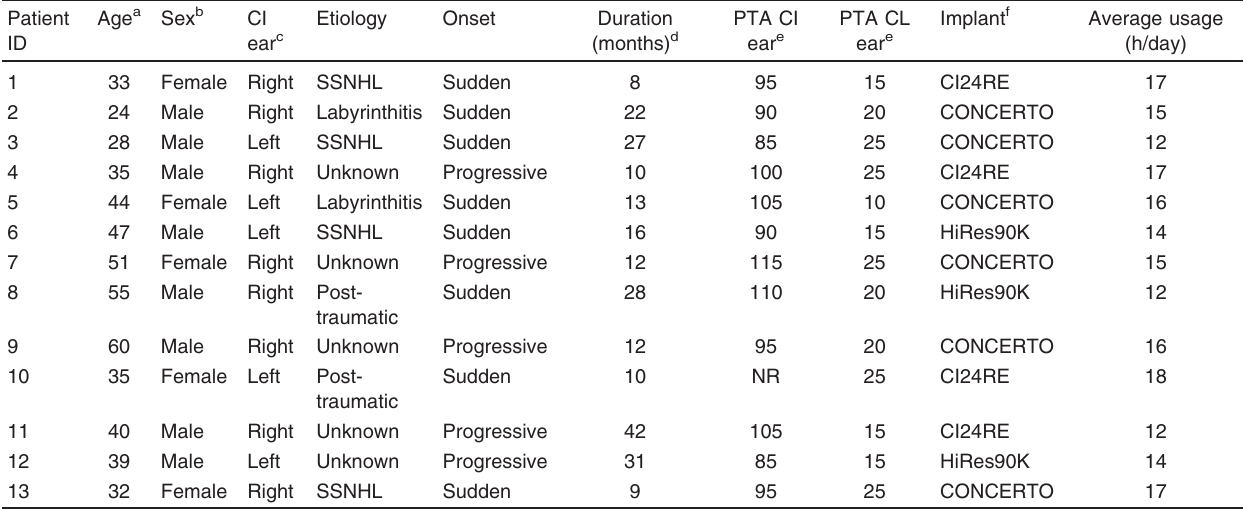
Table 2 Descriptive and demographic features of the study